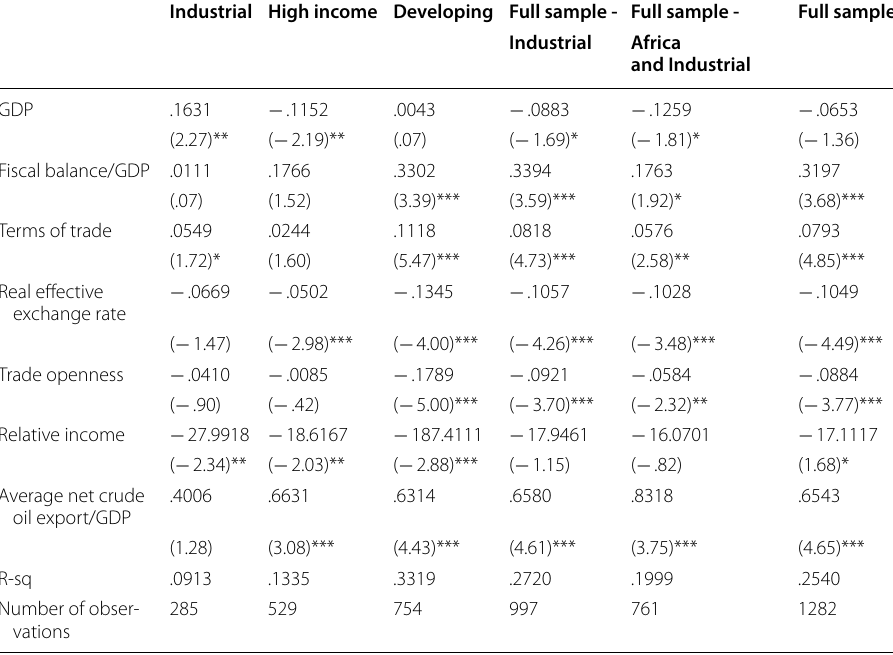
All variables are used in their first differences. t -statistics in parenthesis. *, **, *** indicate significance level at 10%, 5%, 1%, respectively. The estimates for the constants are not